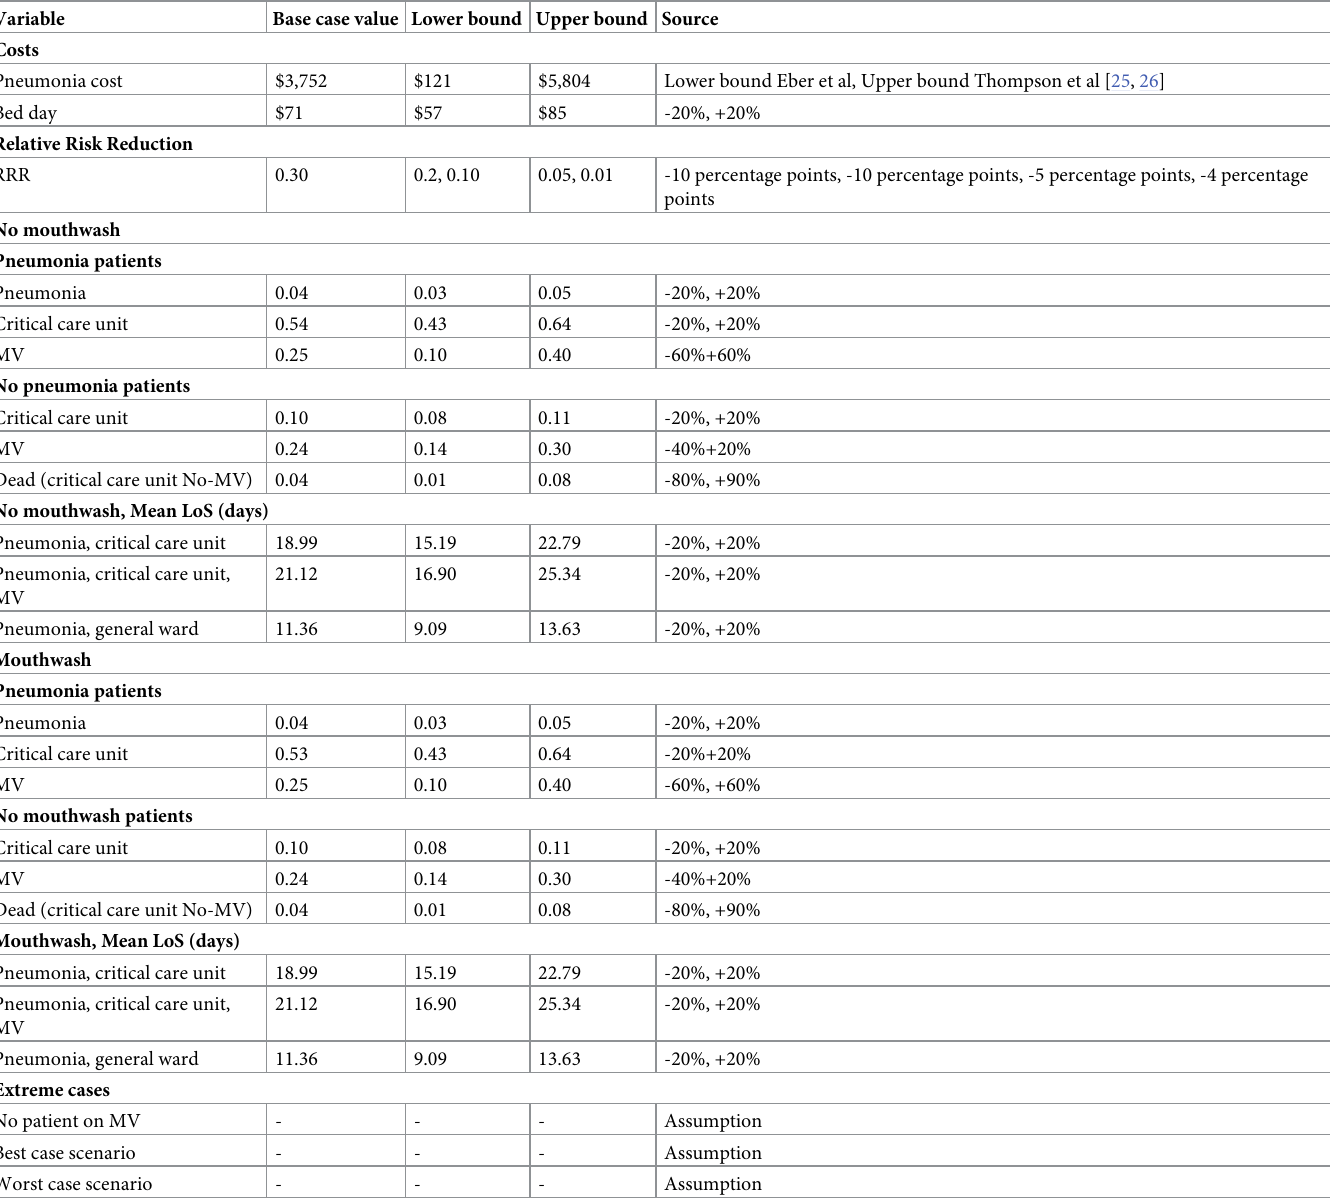
Table 4. Parameter values used in deterministic sensitivity analysis.